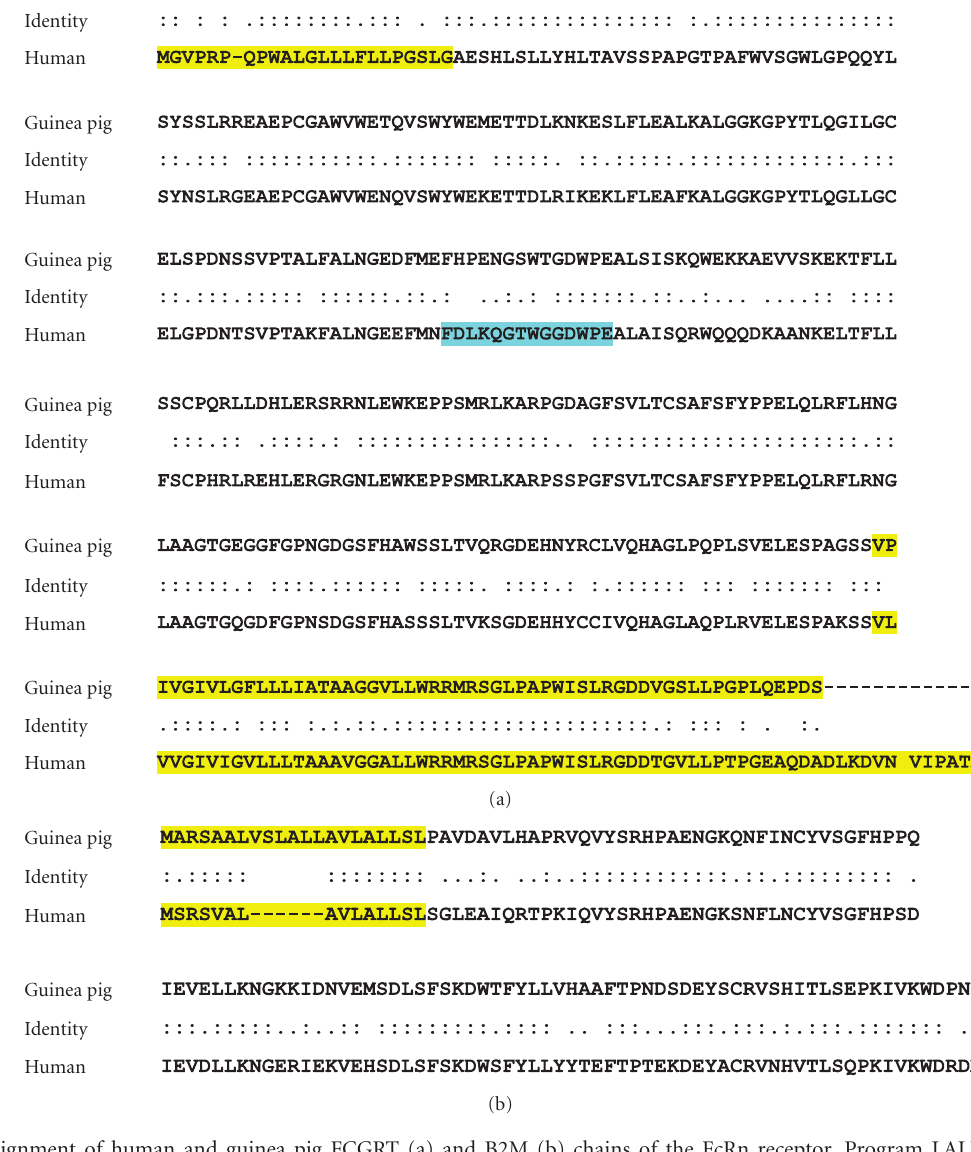
Figure 3: Alignment of human and guinea pig FCGRT (a) and B2M (b) chains of the FcRn receptor. Program LALIGN with matrix BLOSUM50, as described [48] was used. Similar results were obtained using BLAST. Regions highlighted in yellow correspond to signal and transmembrane domains of these chains and were not included in the engineered soluble receptor. The immunogen used for polyclonal anti-FCGRT antibody production is highlighted in